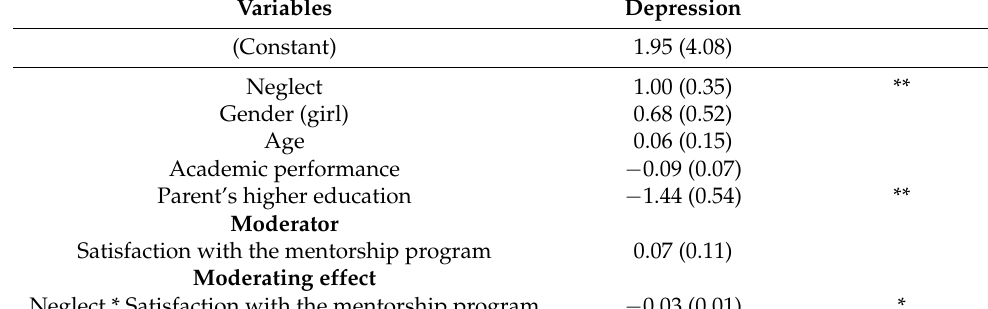
Table 2. Regression results of unstandardized coefficients (standard error) predicting depression.